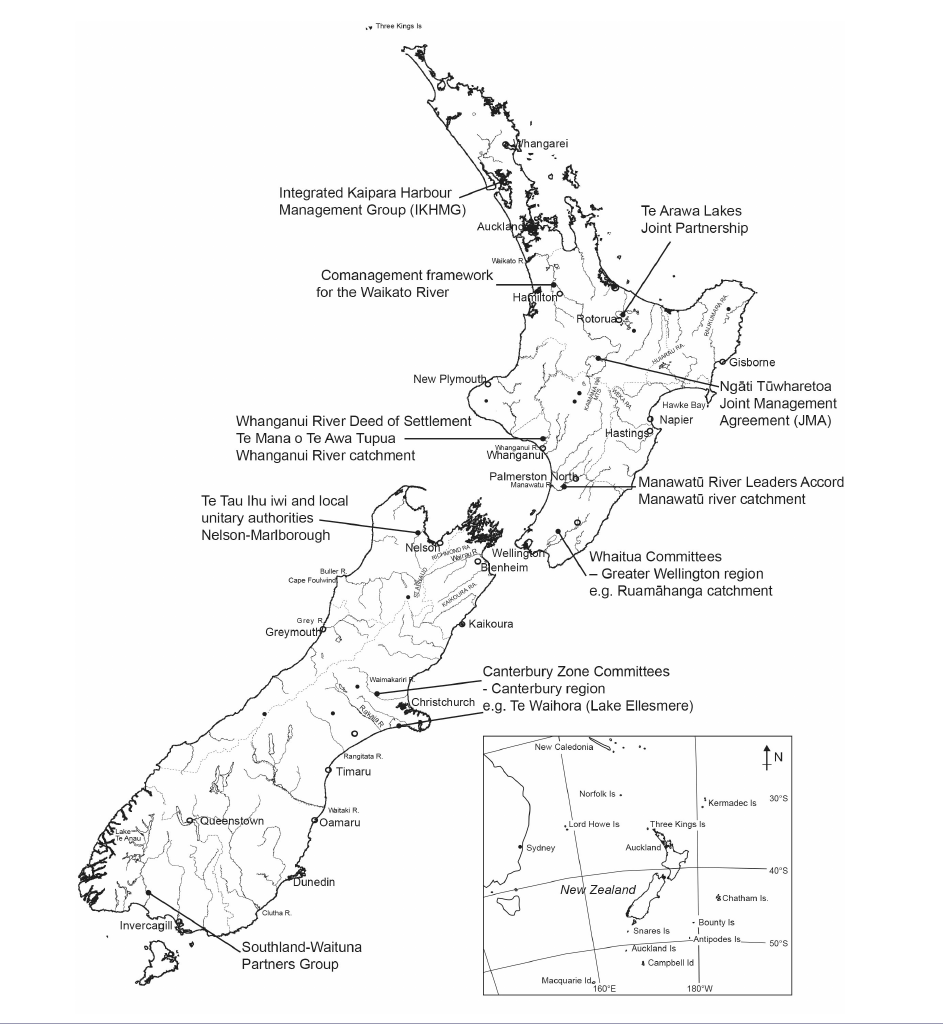
Fig. 2 . Location of selected M ā ori cogovernance and comanagement models in New